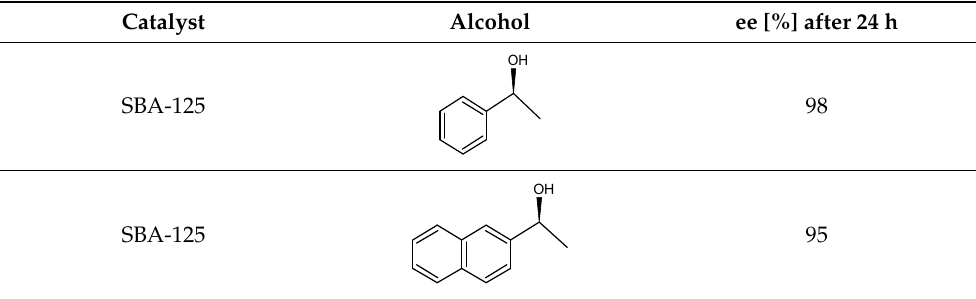
Table 4. Racemization tests on secondary alcohols catalyzed by the covalently bounded Ru(2)- cBn-fSBA.